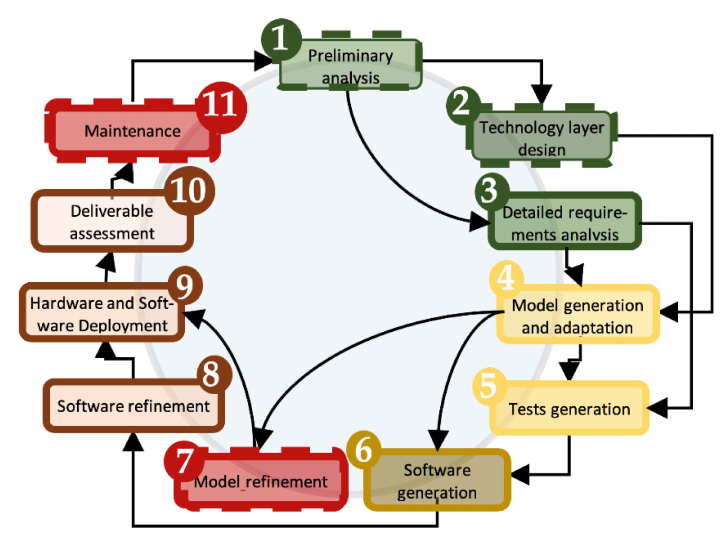
Figure 1. TDDM4IoTS Stages